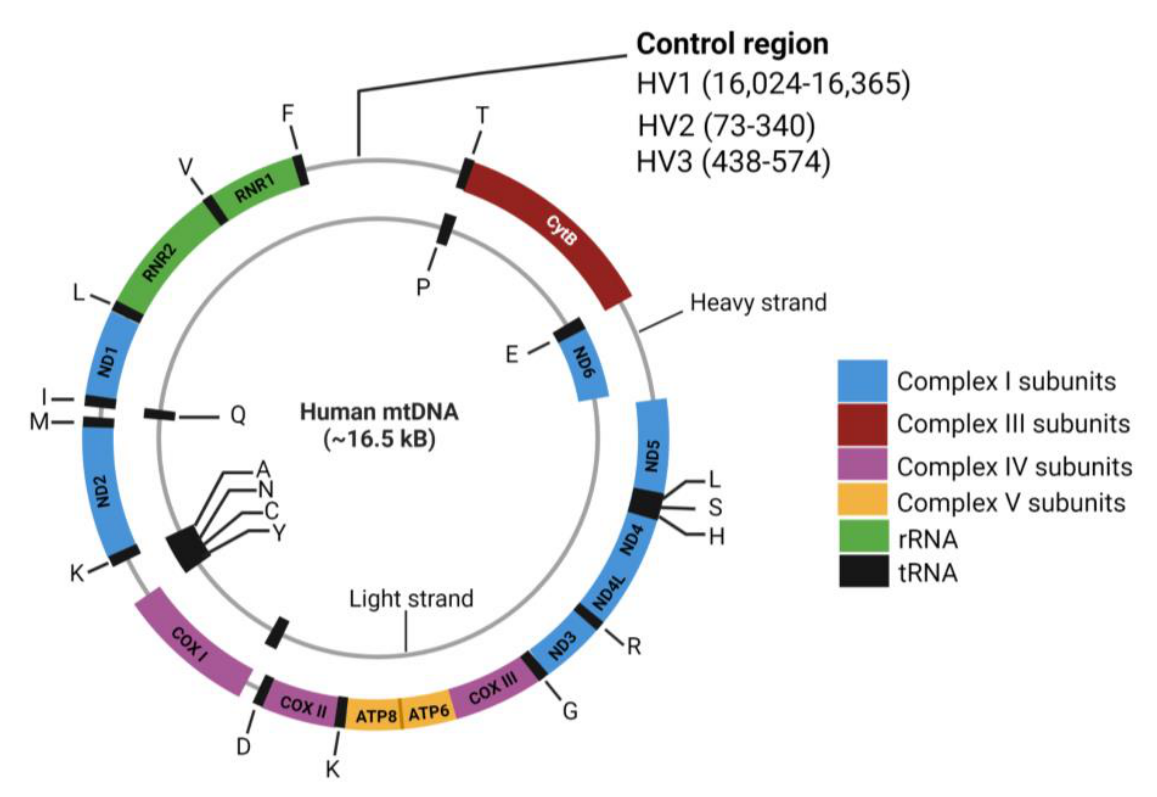
Figure 1. Mitochondrial genome. Mitochondrial respiratory complex function is maintained by both nDNA- and mtDNA-encoded genes. The transcripts of the nDNA-encoded respiratory complex subunits are translated in the cytoplasm and imported into the mitochondria through the mitochon- drial import machinery. Thirteen protein-coding genes in mt genome belong to various respiratory complexes (I: ND1 , ND2, ND3, ND4, ND4L, ND5 , and ND6) ; III: CYTB , IV: COXI , COXII, COXIII , and V: ATP6 and ATP8 ). The noncoding portion of mt genome consists of rRNA and 22 tRNA genes that are important for translation of the mtDNA-encoded transcripts. The control region, sometimes referred to as the D-loop, consists of three hypervariable segments termed HV1, HV2, and HV3. This region also contains replication initiation sites and promoter regions for transcription of the two mtDNA strands. Figure was created with BioRender.com (accessed on 19 February 2023).